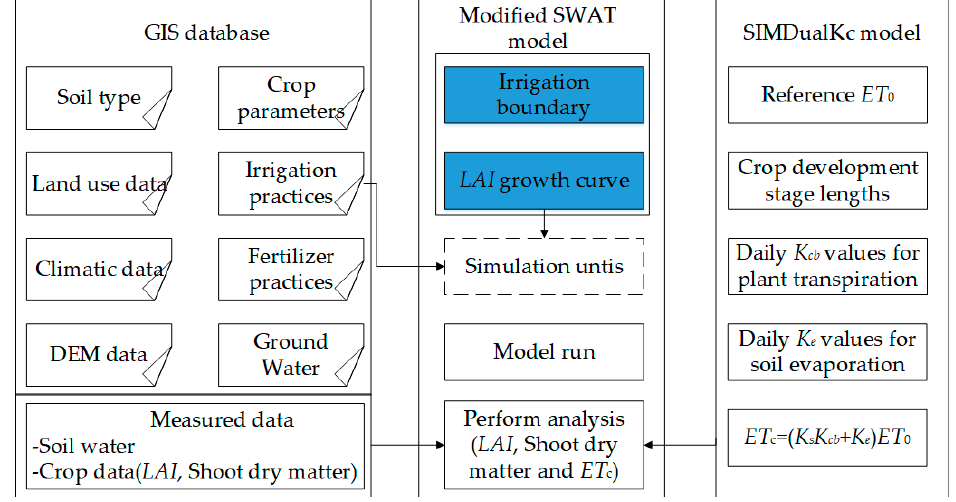
Figure 2. Schematic diagram of the coupling modified SWAT2009 and SIMDualKc model.